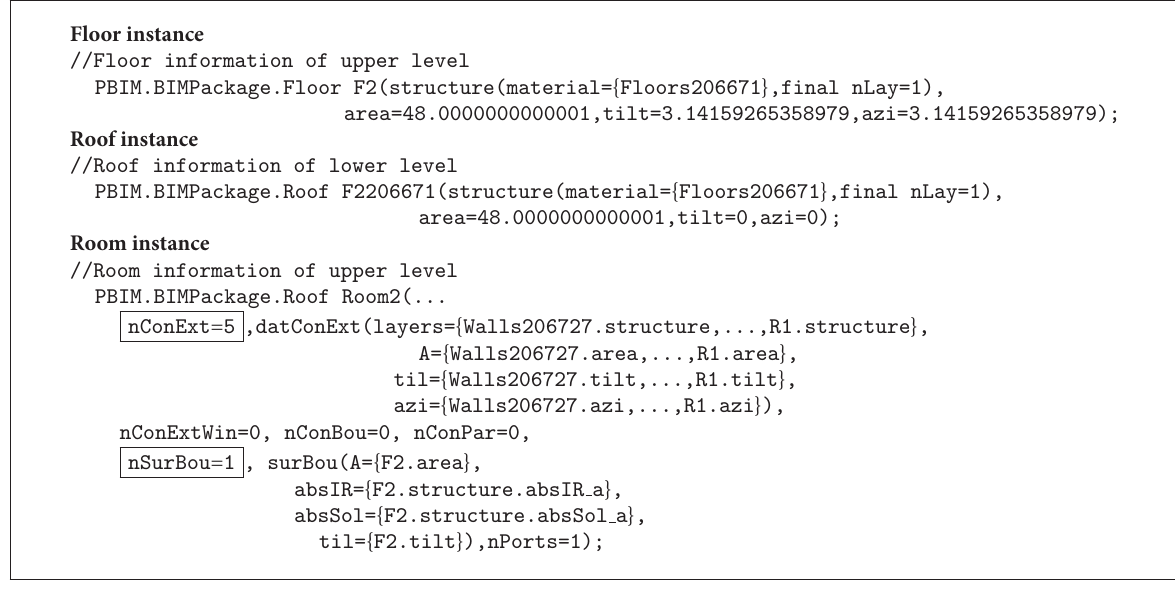
Algorithm 5: Generated ModelicaBEM code block of the two-story building model presenting the floor instance, the roof instance, and the room instance at the upper level.